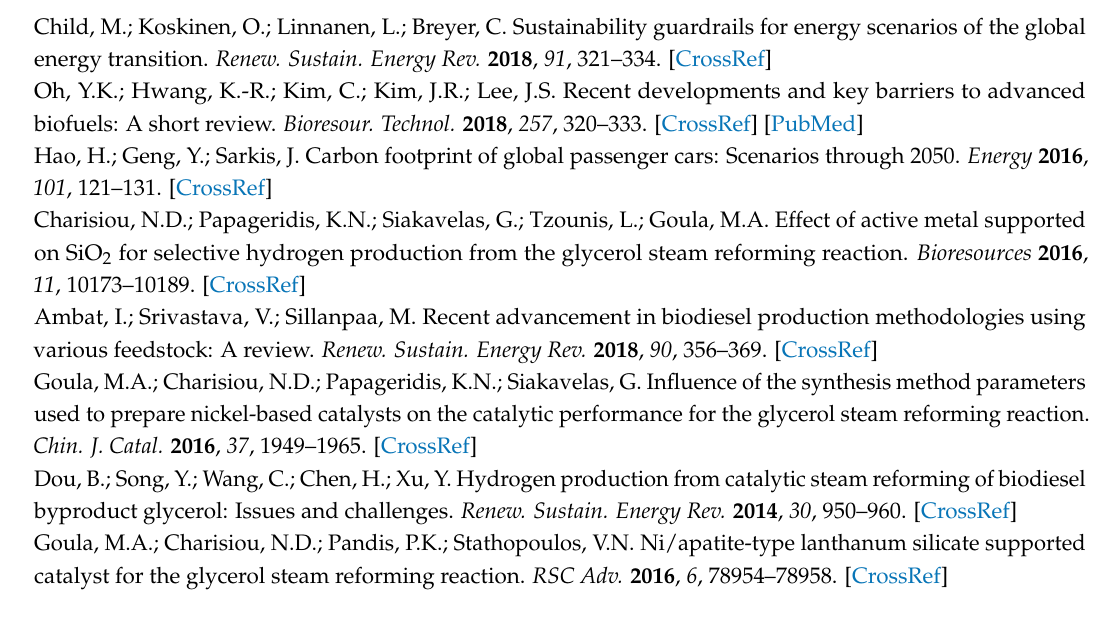
Figure S1: Reproducibility of the Ni/CeSm5Cu experimental results: (a) Glycerol conversion into gaseous products, (b) H 2 yield (c) H 2 selectivity, (d) CO 2 selectivity, (e) CO selectivity, (f) CH4